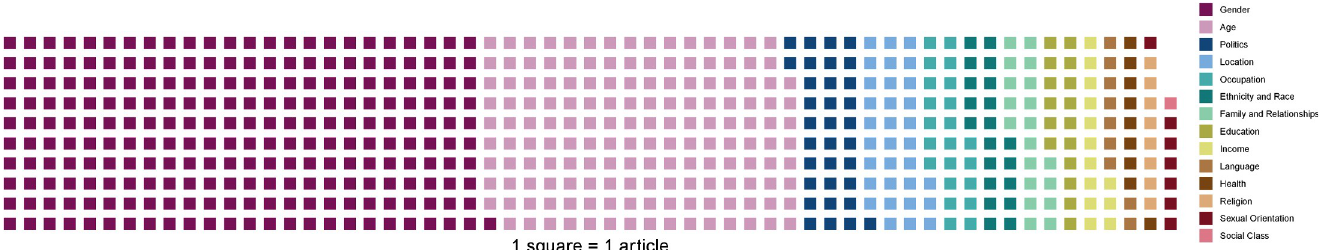
PLOS ONE | https://doi.org/10.1371/journal.pone.0207112 November28,